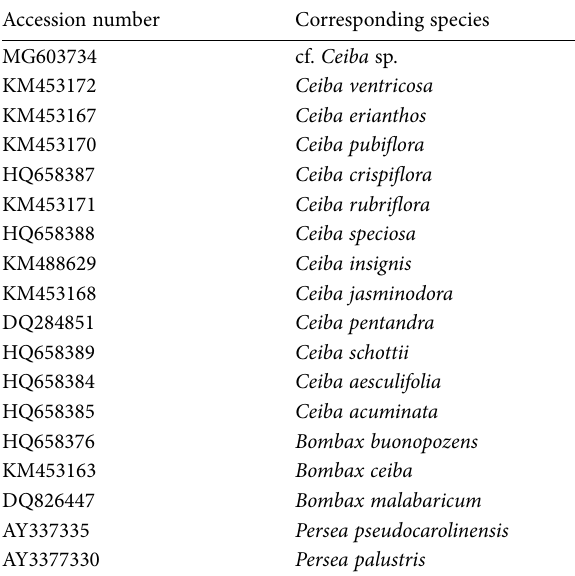
Table 1. The eighteen species used for constructing the phylogenetic tree for cf. Ceiba sp. with their accession numbers.